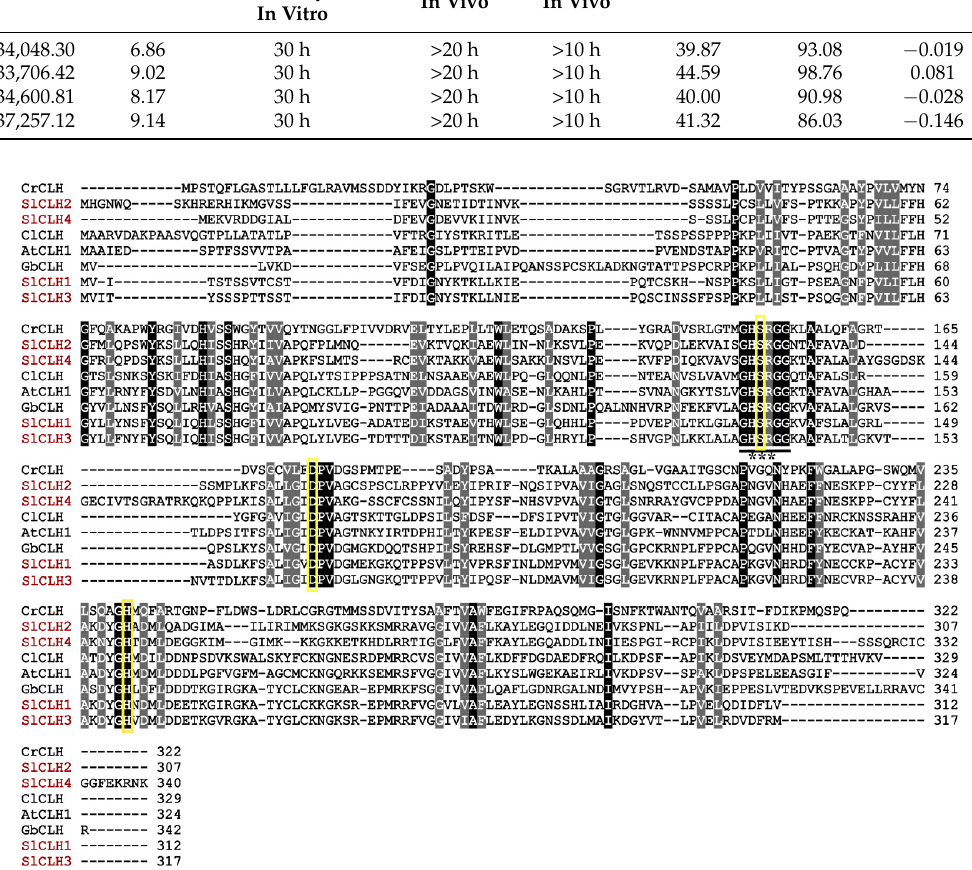
Figure 2. Alignment of amino acid sequences of various CLHs. The sequences of CLHs from Arabidopsis thaliana ( AtCLH1 ), Ginkgo biloba ( GbCLH ), Citrus limon ( ClCLH1 ), and Chlamydomonas reinhardtii ( CrCLH ) were aligned using Clustal Omega. Asterisks represent lipase motif. The identical amino acids in all CLHs are shaded in black, and identical amino acids in seven out of eight sequences are shaded in gray. The black line represents the conserved GHSXG lipase motif, and the three yellow boxesdenote the putative catalytic triad: Ser, Asp, and His residues.